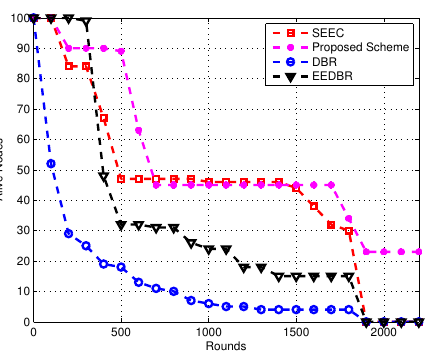
Figure 3. Network lifetime and stability period. SEEC: sparsity aware energy efficient clustering routing protocol; DBR: depth base routing scheme; EEDBR: energy efficient depth based routing